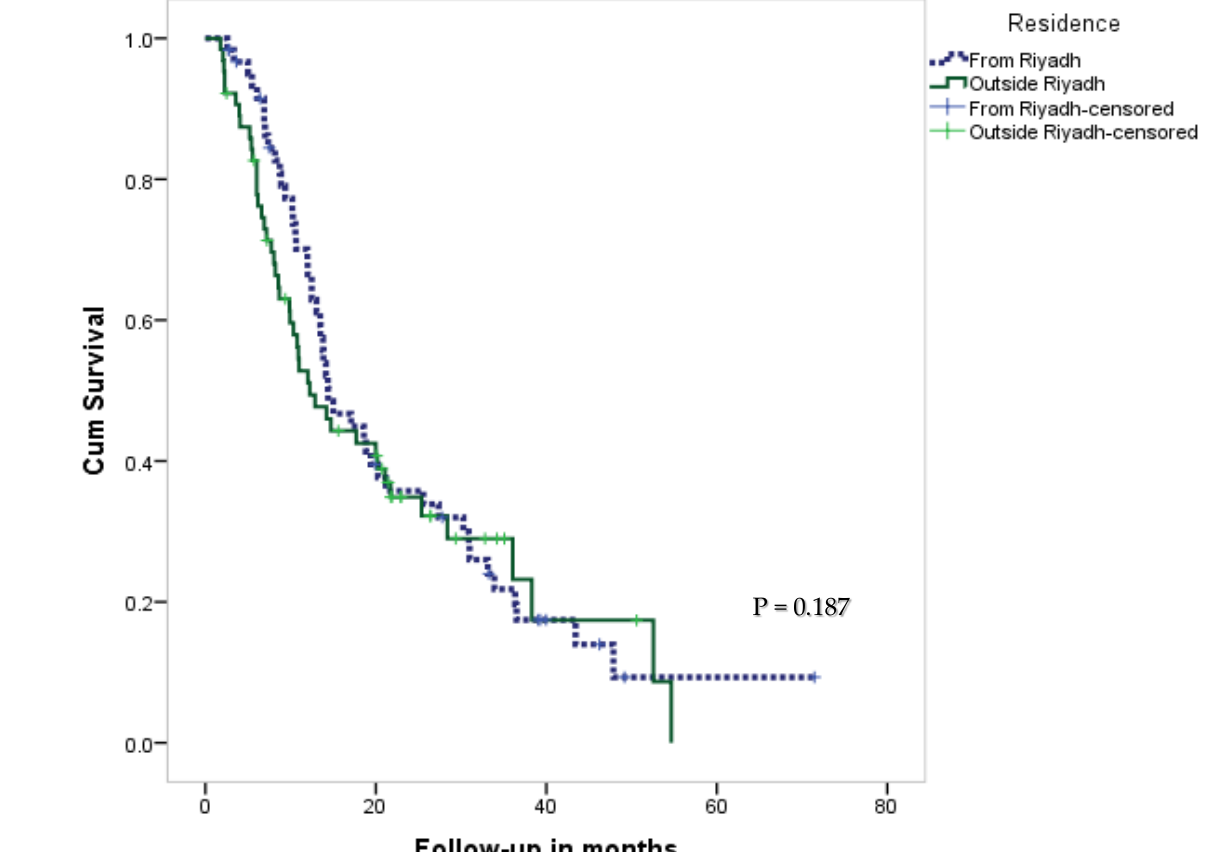
and to 70.3% of patients from outside ( p = 0.078). In terms of RT, 79.7% of patients from